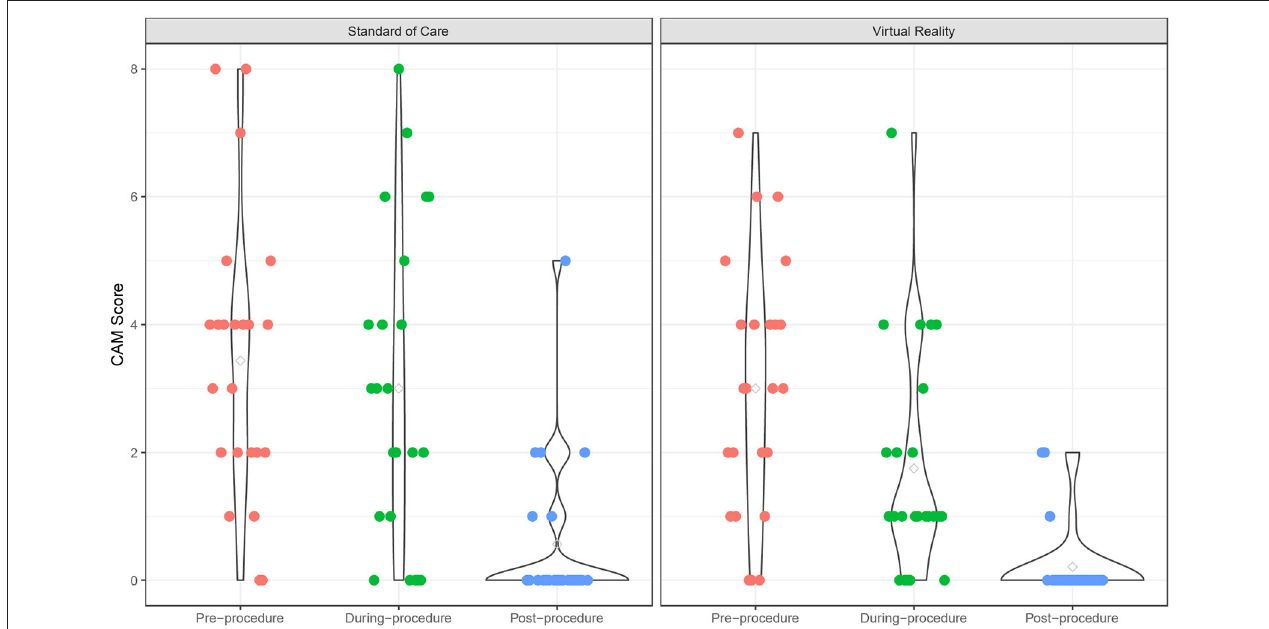
FIGURE 1 | Children’s Anxiety Meter over time. Anxiety scores of Virtual Reality (VR) and SOC groups as measured by the Children’s Anxiety Meter (CAM).